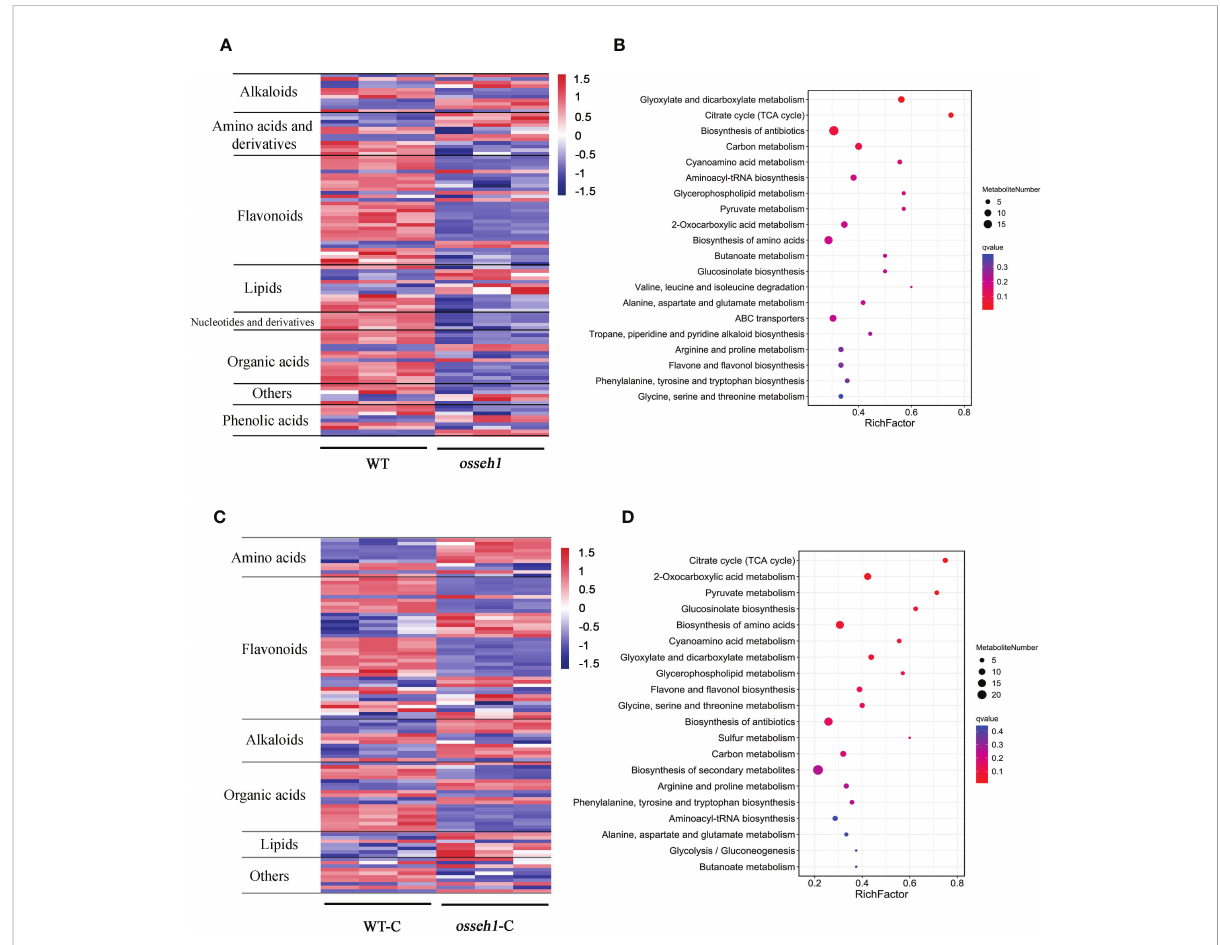
FIGURE 3 Differentially accumulated metabolites (DAMs) between osseh1 lines and WT plants under normal condition and cold stress. (A) Heatmap of DAMs between osseh1 lines and WT plants under normal condition. (B) The top 20 KEGG pathways of DAMs under normal condition. (C) Heatmap of DAMs between osseh1 lines and WT plants under cold stress. (D) The top 20 KEGG pathways of DAMs under cold stress. WT, WT under normal condition. WT-C, WT under cold treatment. osseh1 , osseh1 lines under normal condition. osseh1 -C, osseh1 lines under cold